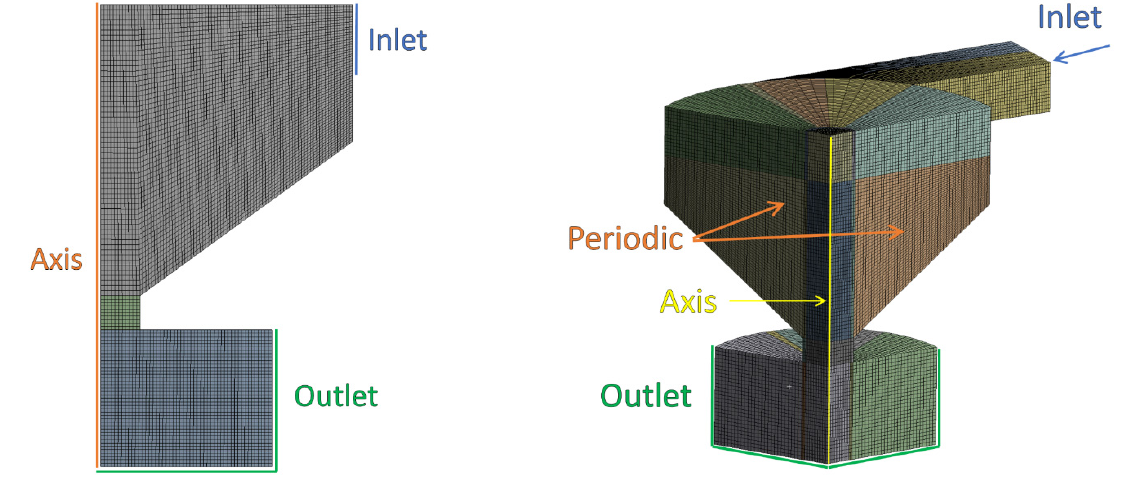
Figure 3. ( Left ): The 2D mesh. ( Right ): The 3D periodic mesh with inlet port.